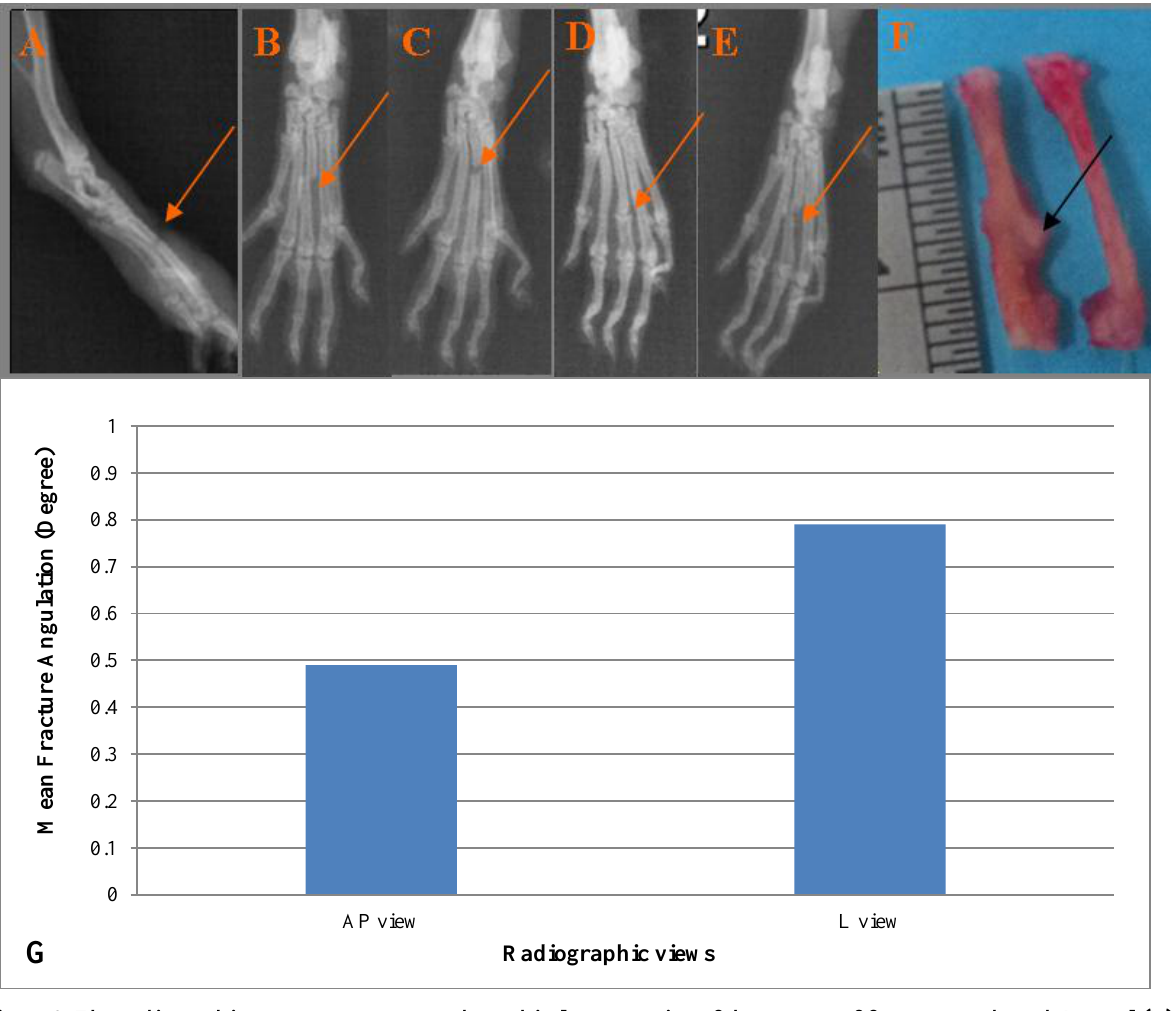
Figure 6. The radiographic, gross appearance and graphical presentation of the pattern of fracture produ ced. Lateral (L) and anteri or posterior (AP) views of representative radiographic with evidence of mid shaft fracture produced. A is a lateral view, (B, C and D) AP view radiographic with evidence of fracture angulations, (G) graphical presentation of radiographic degree of fracture angulations in lateral and anterior posterior view. There was no significant difference between two radiographic views. A, B, C and E radiographs were taken immediately after surgery, while E was taken 1 week after surgery. F is a gross appearance of fractured and control bones 2 weeks after surgery showing gross